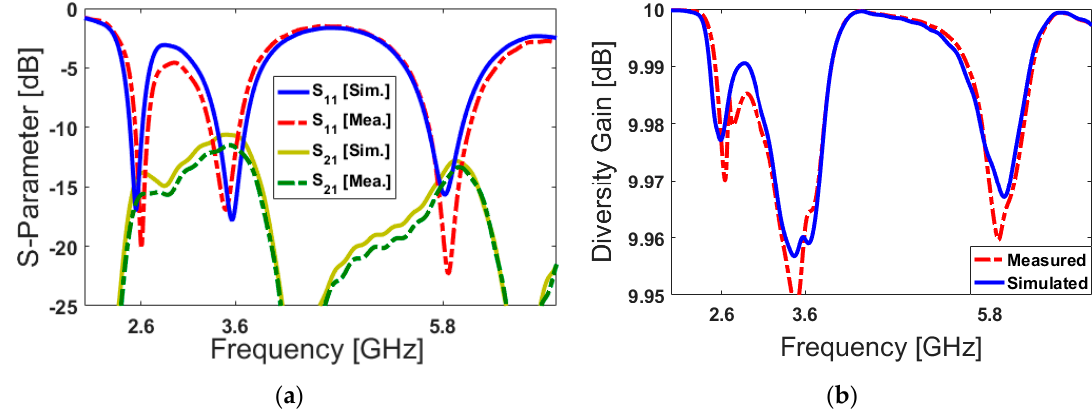
Figure 11. Measured and simulated ( a ) S-parameters and ( b ) diversity gain of the two adjacent PIFAs.